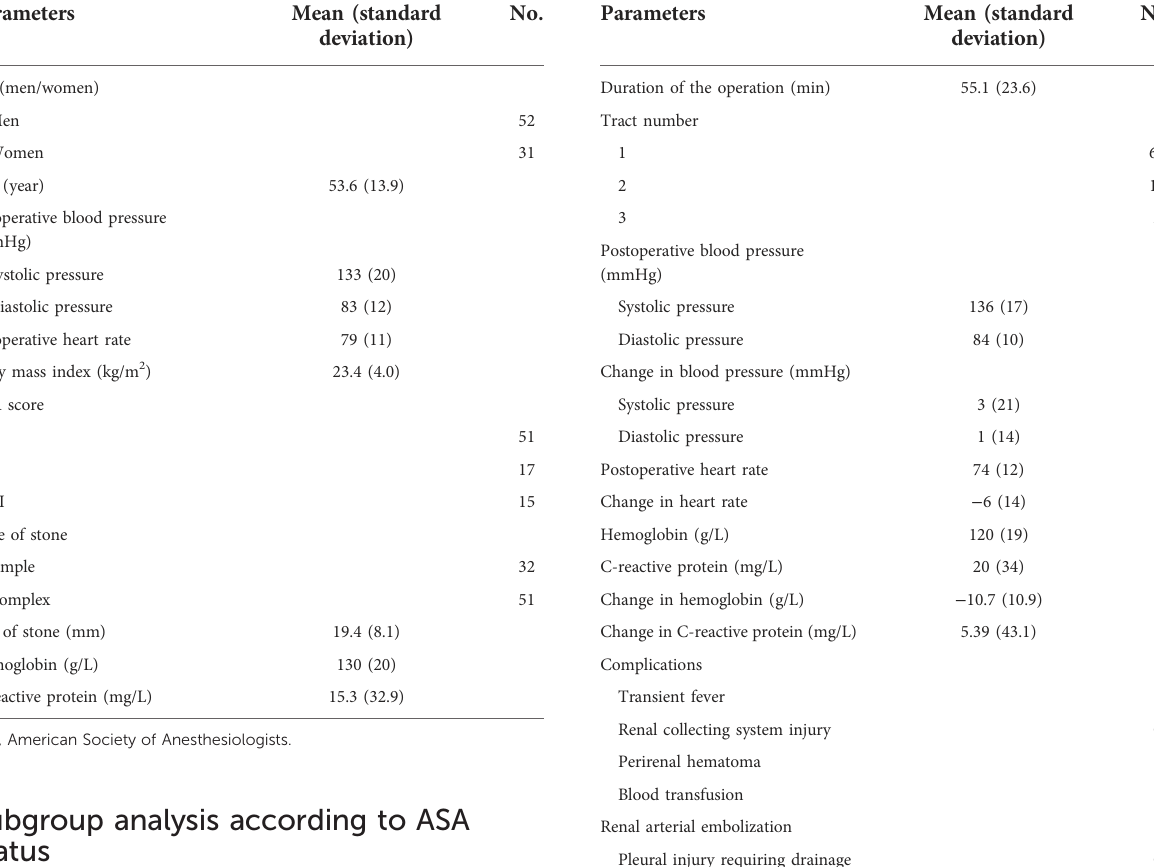
TABLE 1 Characteristic of the included patients. TABLE 2 The main clinical results of the